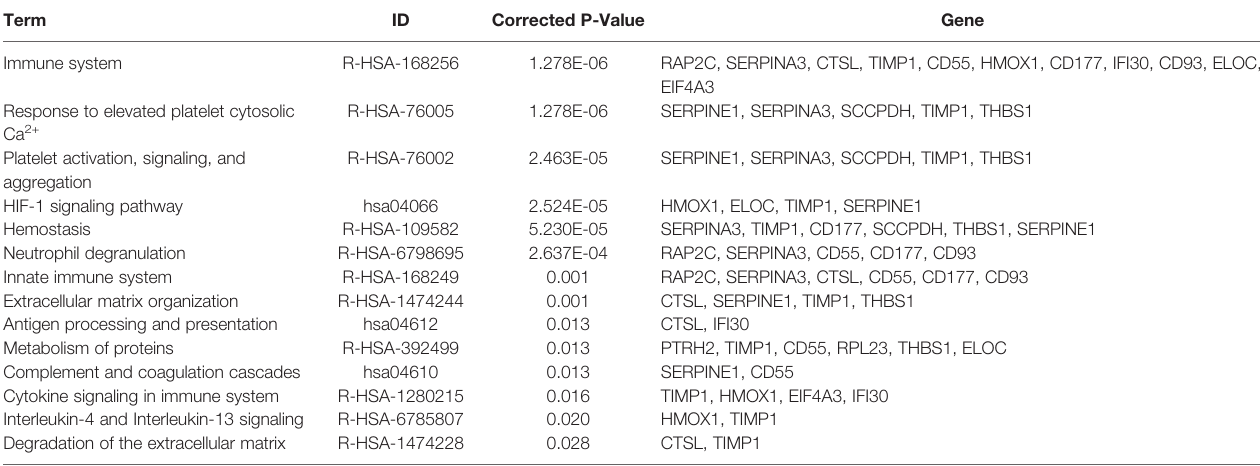
TABLE 2 | KOBAS pathway enrichment